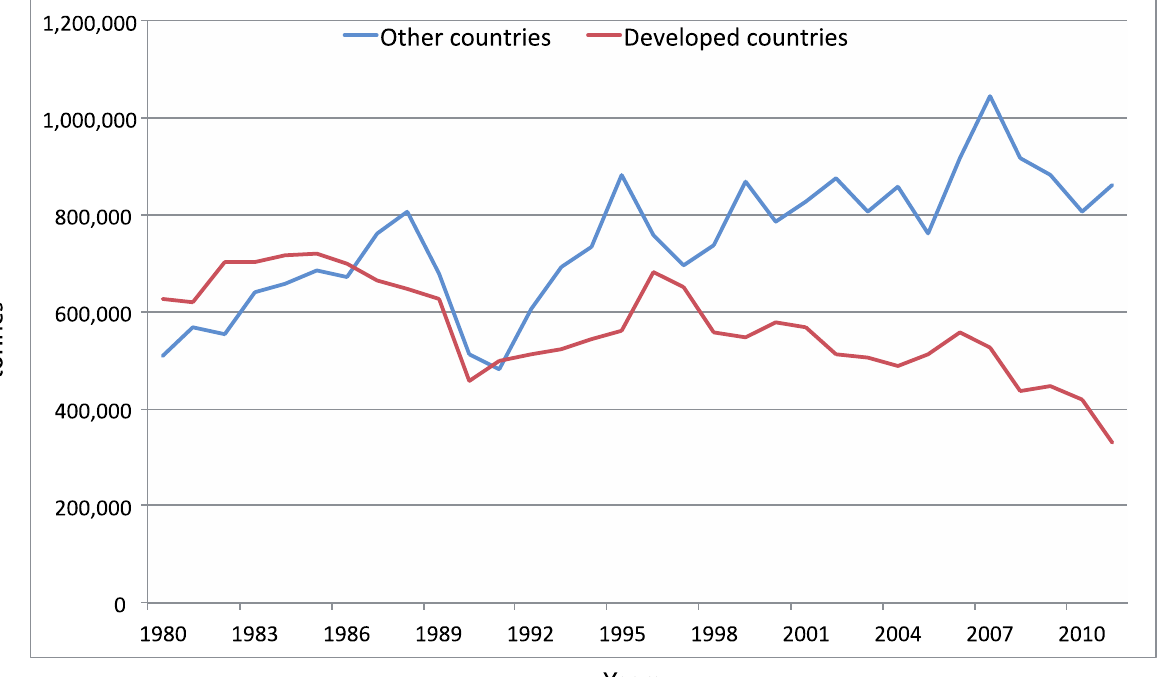
Figure 4. Capture production in the Mediterranean (in tons). (source: FAO